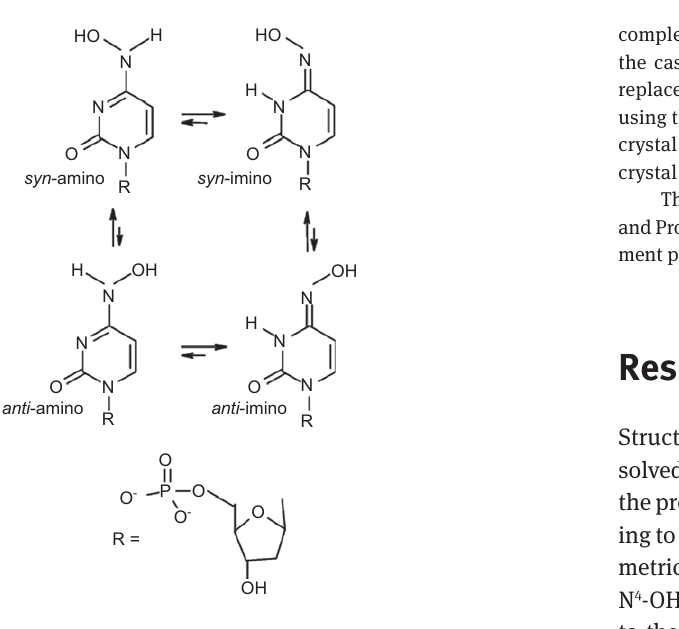
Figure 1 Amino-imino and syn - anti equilibria for N 4 -hydroxy deriva- tives of